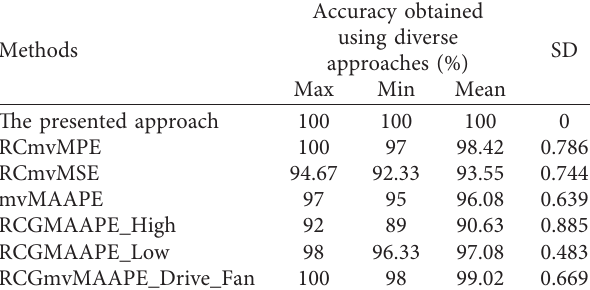
Figure 14: The diagnostic result of the seven feature extraction models in 20 trials. Table 2: Recognition result of seven methods in 20 trials.